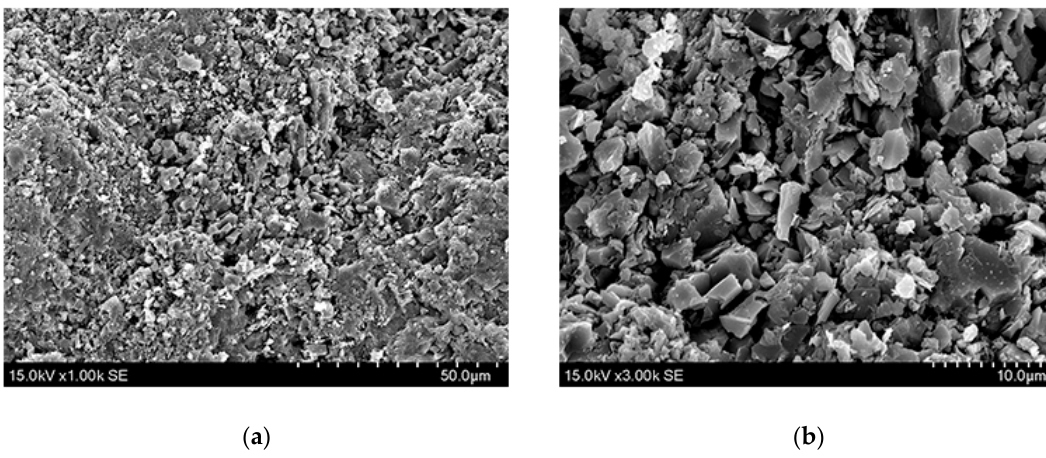
Figure 1. Micrographs of YaMeng black sandstone by Scanning Electron Microscope (SEM) ( a ) The micrograph with scale of 50.0 µ m. ( b ) The micrograph with scale of 10.0 µ